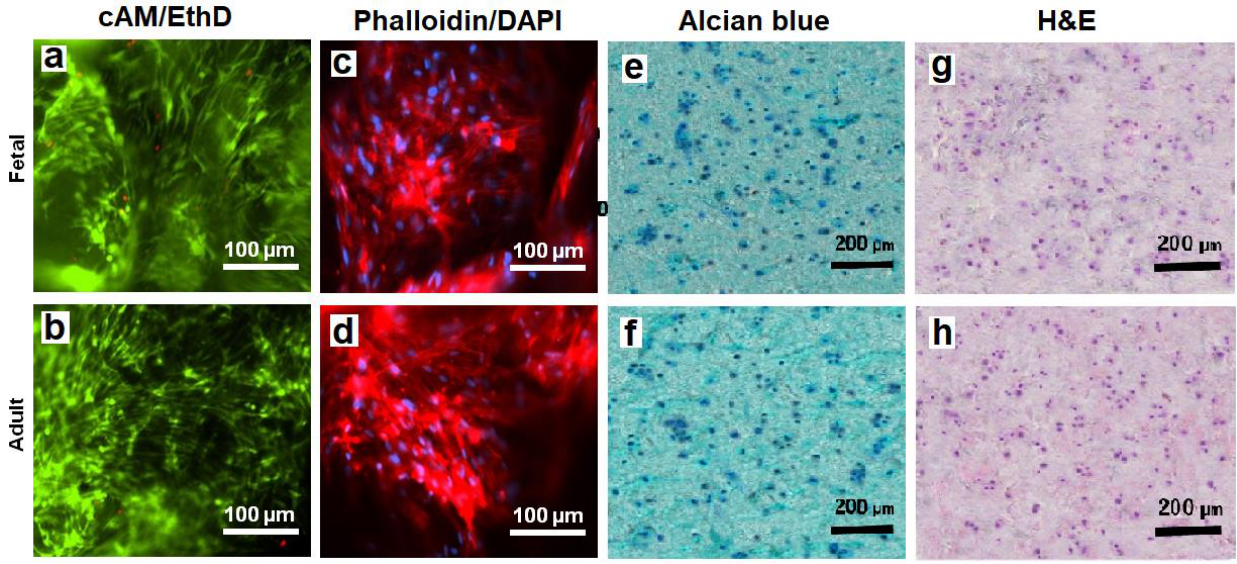
Figure 8. The images of sectioned fetal (first row) and adult (second row) CMG-MSCs/Alg hydrogels with cAM/EthD staining for live/dead cells ( a , b ), Phalloidin/DAPI staining for cell shape ( c , d ), Alcian blue staining for GAG ( e , f ), and H&E staining for cell distribution ( g , h ); the CMG loading in hydrogel constructs was 50%, the CMGs average size was 190 μm, and the hydrogel constructs were cultured in chondrogenic medium for 21 days. The scale bar in cAM/EthD and Phalloidin/DAPI images is 100 µm; the scale bar in Alcian blue and H&E images is 200 µm.